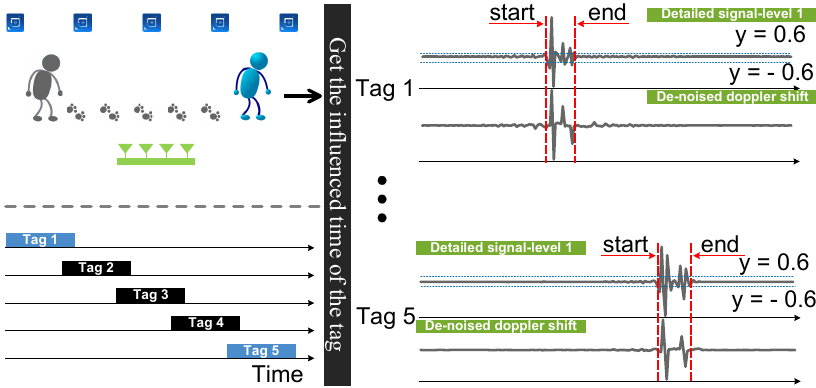
Figure 7. Segment the beginning and the ending of affected time of the